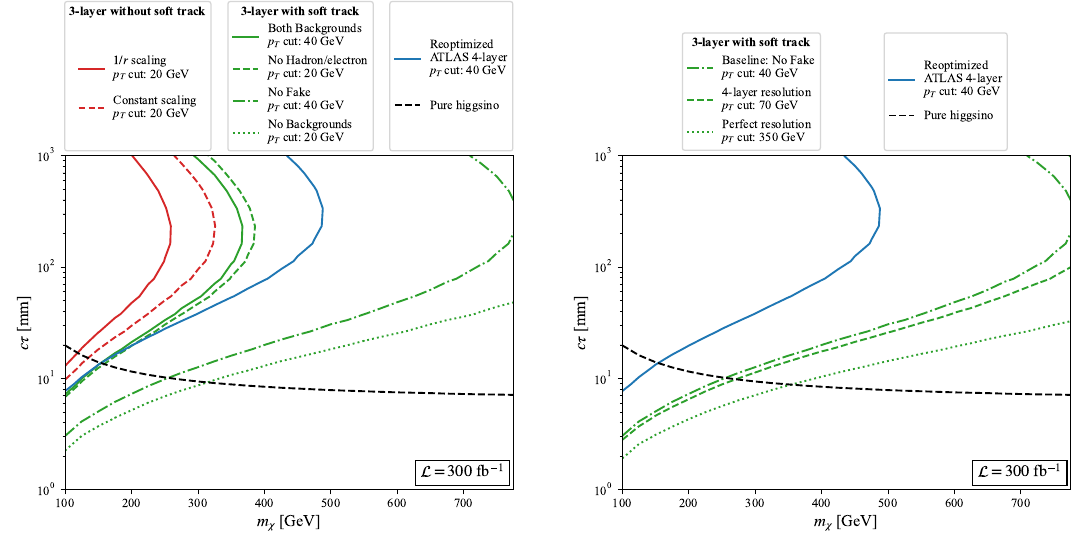
Figure 12 . Left: projection of figure 9 to the LHC Run 3 CM energy and luminosity. Right: projection of figure 11 to the LHC Run 3 CM energy and luminosity. The background benchmarks are chosen as described in the captions of the Run 2 figures. The increase of the fake tracklet background due to the higher pile-up numbers in Run 3 is described in the main